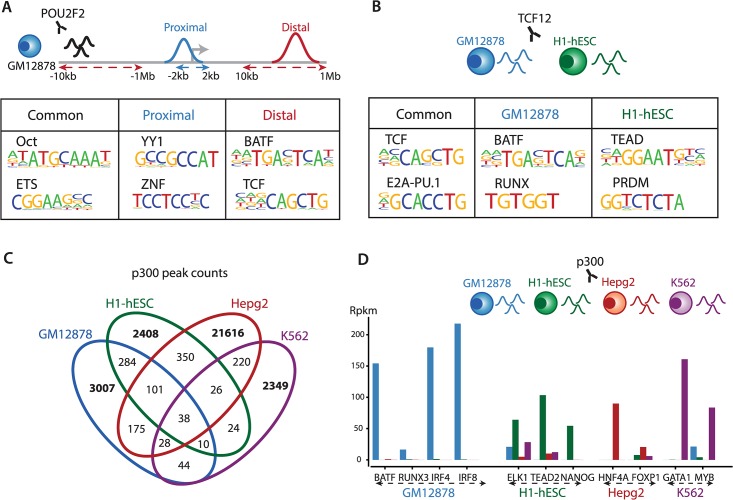
Candidate binding partners for a transcription factor are dependent on genomic context, cell type, and expression levels of partners.(A) Multitask learning identifies different candidate binding partners of POU2F2 at proximal and distal locations to genes. The proximal partners are associated with factors that preferentially bind to CG-rich motifs whereas the distal partners are associated with cell-type specific regulators. As expected, the POU/octamer motif is present in both contexts. (B) Similarly, TCF12 binding profiles in GM12878 and H1-hESC shows preference for cell-type specific regulators at the cell-type specific sites, and the TCF motif is associated with peaks of both cell types. (C-D) The enhancer bound factor p300 shows highly cell-type specific binding and predicted TF signals. The cell-type specific expression of the p300 candidate binding partners partially explains the differing binding profiles of p300 across cell types.